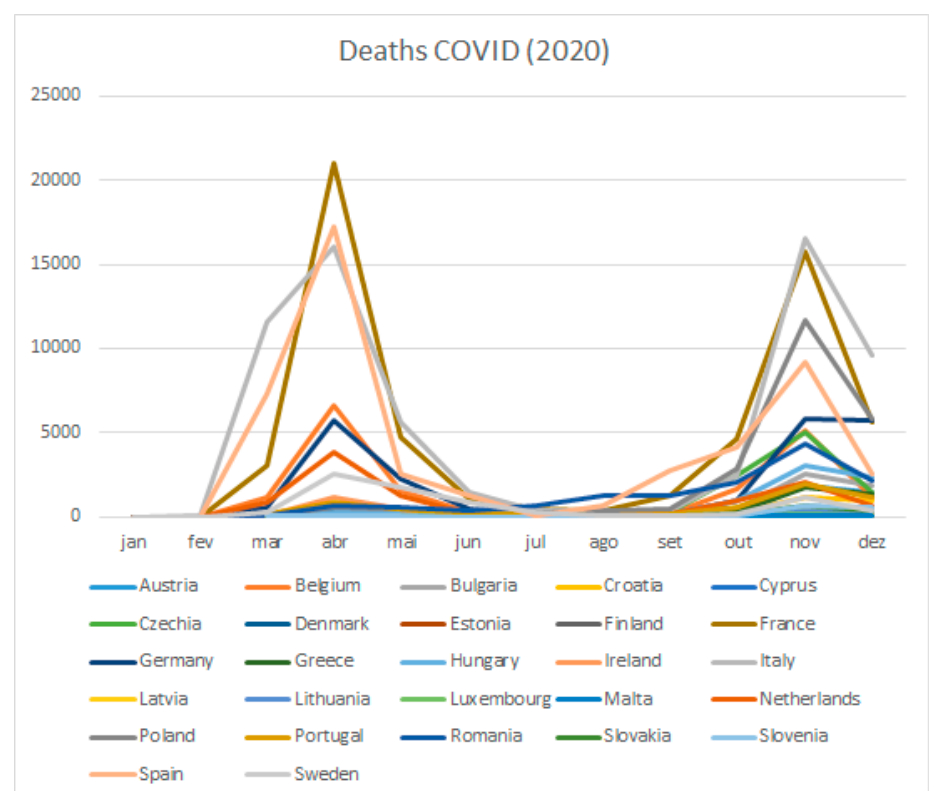
Figure 3. COVID-19 deaths, 2020 by country.